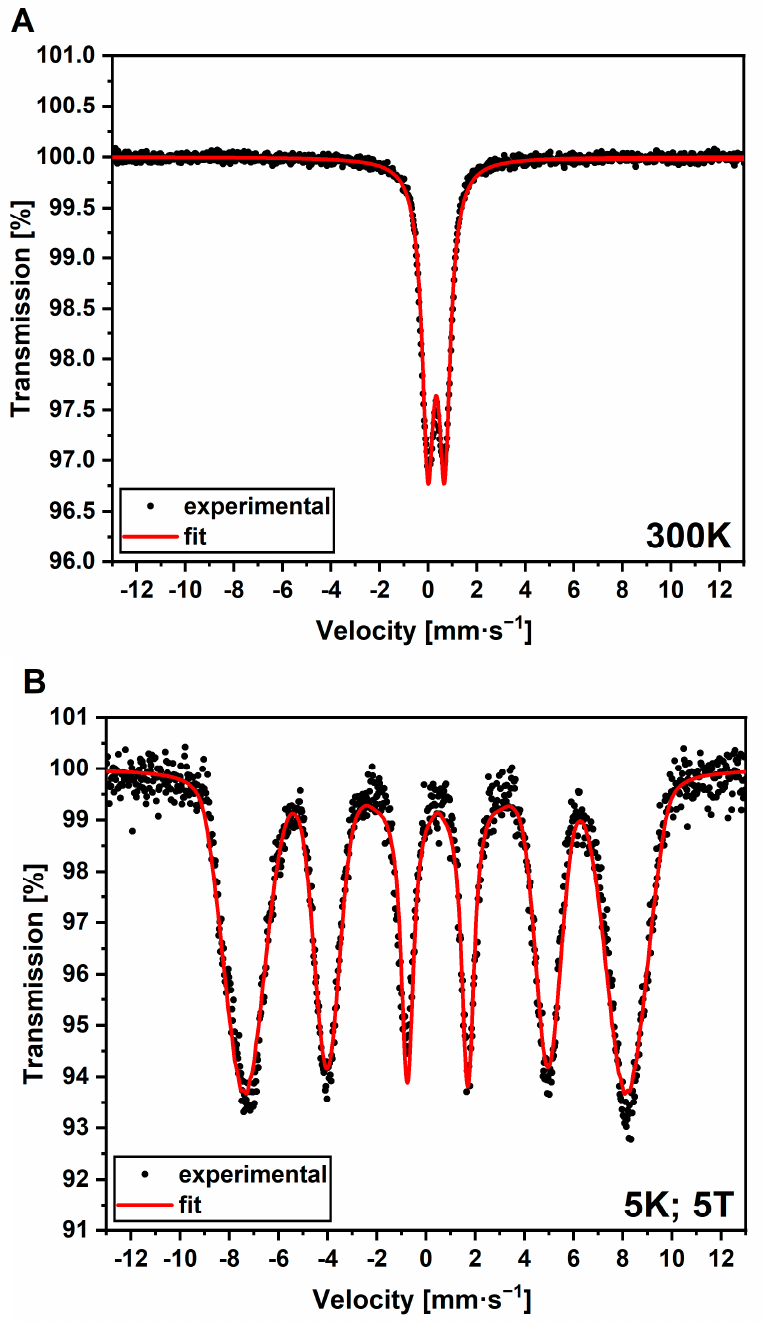
Figure 4. Mössbauer spectra of AuBSA-Fe recorded ( A ) at room temperature and ( B ) at the 5 K and 5 T external magnetic field.